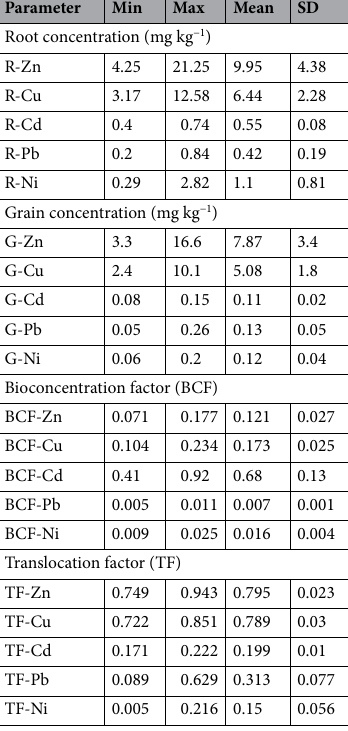
Table 4. Summary statistical attributes of the concentration of heavy metals in corn root (R) and grain (G) along with their BCF and